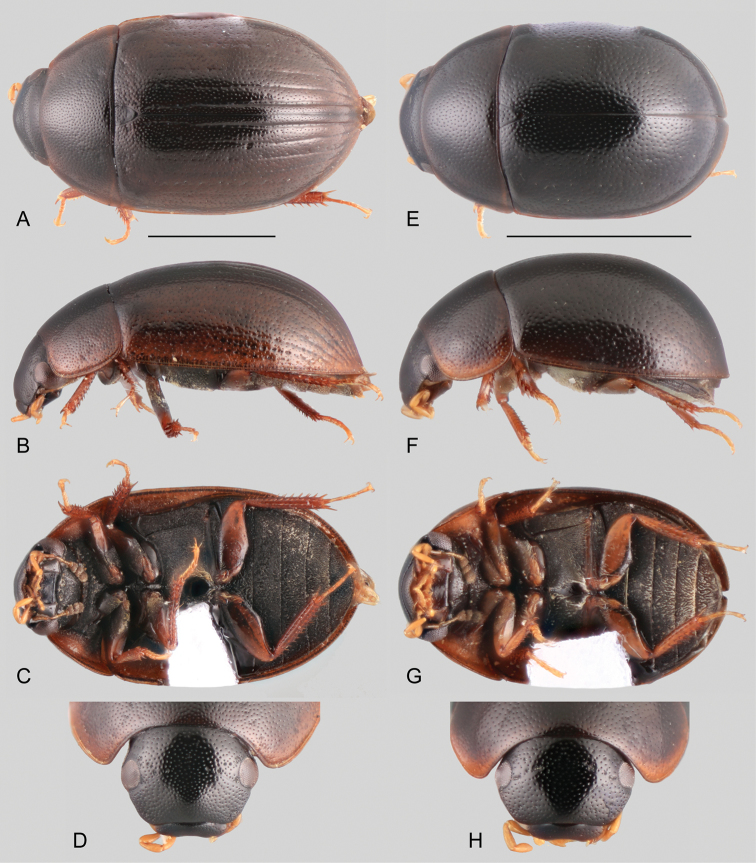
Habitus of Ephydrolithus spp.: A–DEphydrolithusogmos: A dorsal view B lateral view C ventral view D head, dorsal view. E–HEphydrolithusminor: E dorsal view F lateral view G ventral view H head, dorsal view. Scale bars: 1 mm.